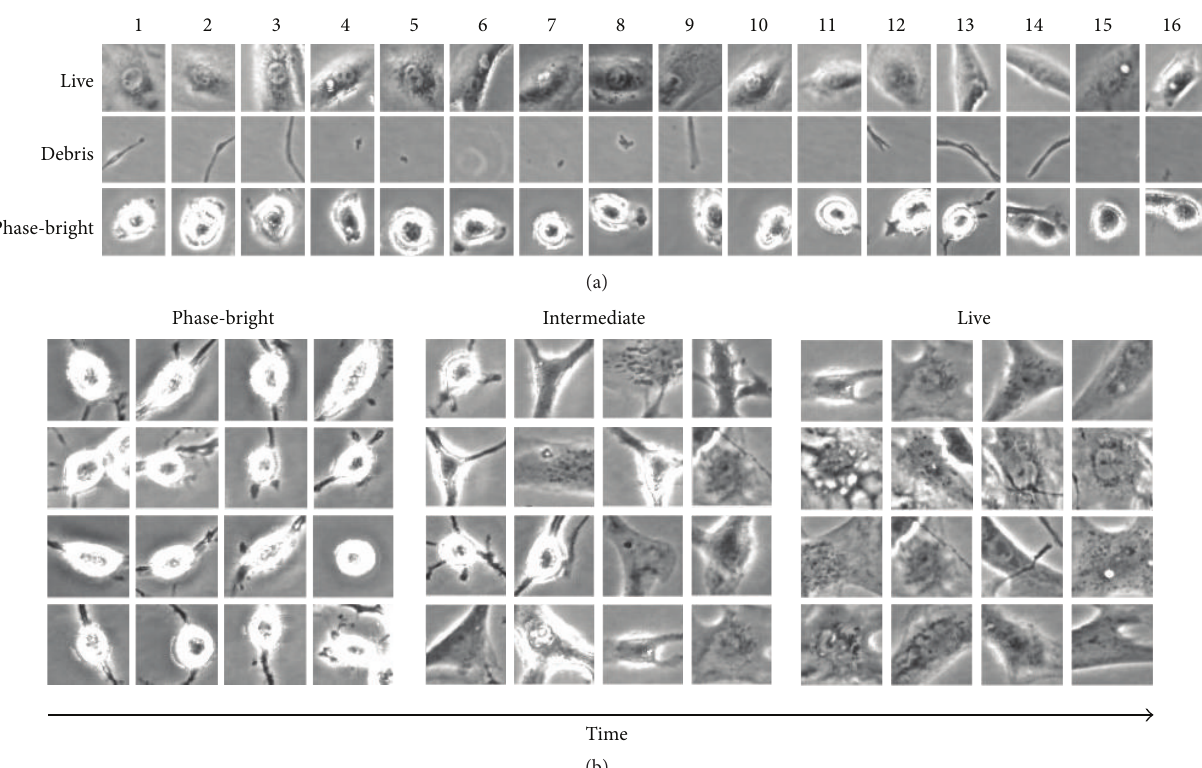
Figure 1: Sample library generated using the Cell-IQ® Analyser software. (a) Samples within the library are divided into three categories: live, phase-bright, and debris. Examples are added to the library to teach the software into which category a cell should fall. (b) Transition of human nucleus pulposus cells from a phase-bright category to a live, fibroblast category, over 48